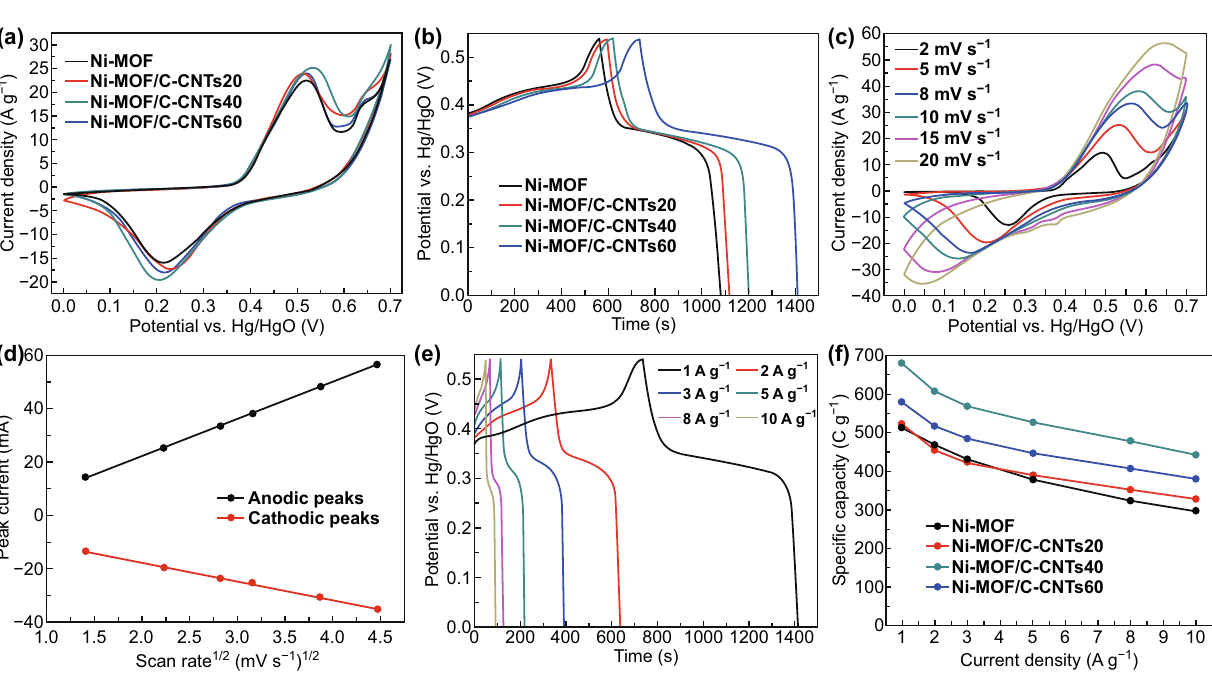
Fig. 4 Electrochemical evaluation measured in 3 M KOH electrolyte with a three-electrode system. a CV curves at 10 mV s −1 and b GCD curves at 1 A g −1 for Ni-MOF and a series of Ni-MOF/C-CNTs nanostructures. c CV curves at different scan rates, d the relationship between the scan rate and peak current density, and e GCD curves at various current densities for Ni-MOF/C-CNTs40. f Specific capacities for Ni-MOF and a series of